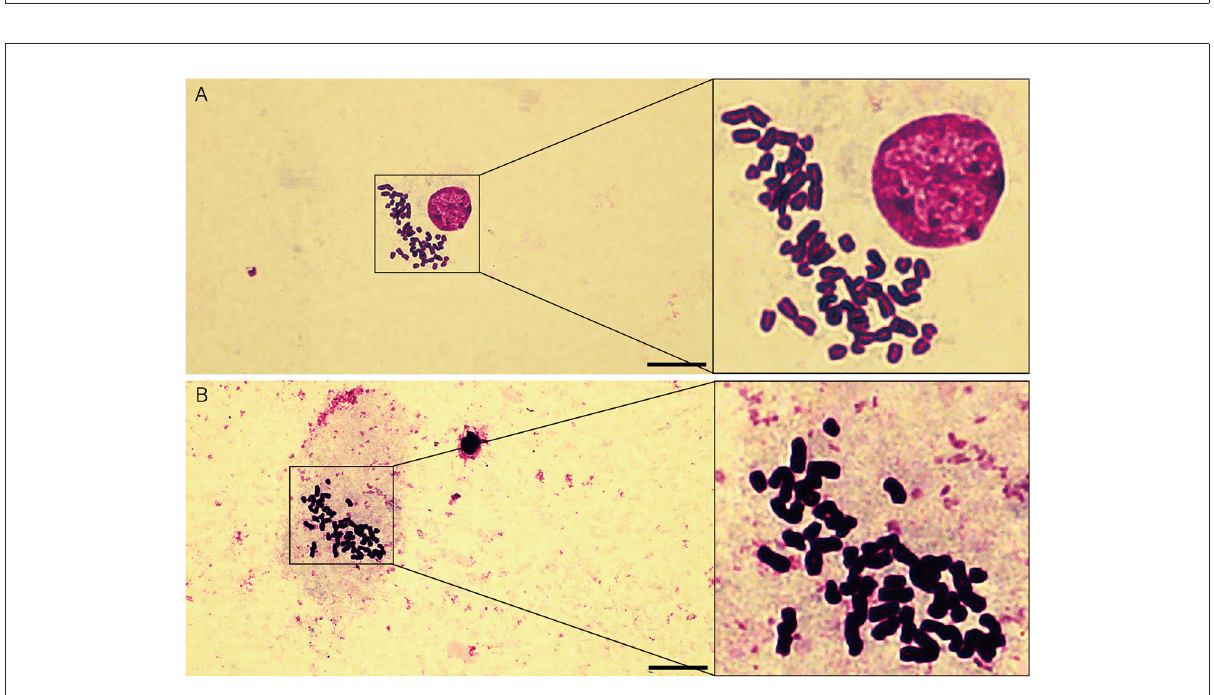
FIGURE3 Chromosomes analysis of immortalized OFTu and primary OFTu. (A) Immortalized OFTu (B) Primary OFTu (passage 15). Scale bar = 20 µ m.